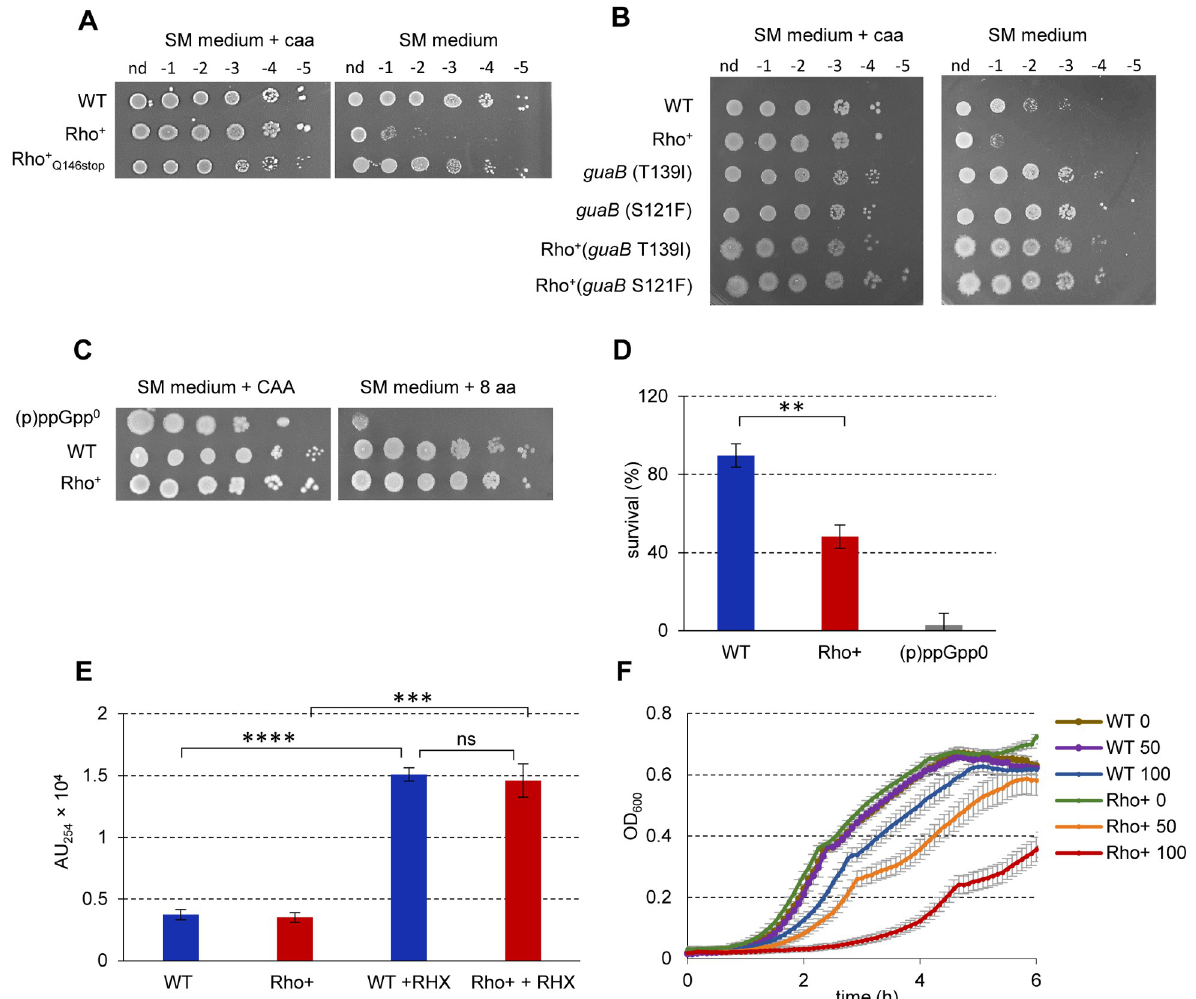
Fig 8. Adaptation of B . subtilis Rho + cells to a sudden nutrient downshift. ( A ) Rho + cells exhibit phenotypic amino acid auxotrophy. B . subtilis WT, Rho + and Rho + Q146Stop cells growing exponentially (OD 600 0.5) in liquid S7 medium containing 0.5% (w/v) of casamino acids (CAA) at 37˚C were spotted in serial dilutions on SM agar plates supplemented or not with CAA (0.5%). Plates were incubated at 37˚C during 18h before imagining. ( B ) Decreasing of GTP levels rescues the auxotrophic phenotype of Rho + cells. B . subtilis WT, Rho + and their respective derivative strains carrying guaB S121F and guaB T139I mutations were cultivated in liquid S7 medium containing 0.5% (w/v) of CAA and tested for the ability to grow in the absence of CAA as in (A). ( C ) Unlike (p)ppGpp 0 cells, the Rho + strain resists to mild nutrient limitations. Isogenic WT, (p)ppGpp 0 and Rho + strains were grown in liquid defined SM medium containing 0.5% (w/v) of CAA and spotted in serial dilutions on SM agar plates supplemented either with 0.5% (w/v) of CAA or with 0.05mg/ml of each of the eight amino acids (valine, isoleucine, leucine, threonine, histidine, arginine, tryptophan and methionine). Plates were incubated at 37˚C during 18h before imaging. In (A, B and C), the experiments were reproduced at least three times and the representative results are shown. ( D , E and F ) Rho + cells exhibit altered resistance to arginine hydroxamate (RHX). ( D ) Isogenic B . subtilis WT, (p) ppGpp 0 and Rho + strains were grown to the middle exponential phase (OD 600 0.5), treated with 500 μ g/ml of RHX for 40 min and plated on LB agar plates. Plates were incubated for 18 h at 37˚C before counting viable cells that formed colonies. Strain survival upon sudden amino acid starvation induced by RHX was estimated as the percentage of viable cells after and before the treatment. Plotted are the average values and SD from three independent experiments incorporating three biological replicas of each strain. Statistical significance was estimated with a two-tailed t-test. The displayed p-value: �� , p � 0.005. ( E ) Increase of ppGpp level following sudden amino acid starvation. B . subtilis WT and Rho + cells were grown in SM medium supplemented with 0.5% (w/v) of CAA to the middle exponential phase (OD 600 0.5) and treated or not with 500 μ g/ml of RHX. Cells were harvested 20 min after addition of RHX, and ppGpp levels were assessed as described (Materials and methods). Plotted are the average values and SD from three independent experiments. The displayed p-values are as follows: ���� , p � 0.0001; ��� , p � 0.001; ns (non-significant), p > 0.05 using two- tailed t-test. ( F ) Growth defect of the Rho + strain in the presence of RHX. B . subtilis WT and Rho + strains were cultivated in LB medium without or with RHX added at concentrations 50 and 100 μ g/ml in a 96-well microplate. Growth of the cultures was monitored by OD 600 measurement at the five-minute intervals using a microplate reader. Plotted curves are the average OD reads of two independent cultures of each strain grown in triplicates at each condition. The analysis was performed three times; the results of a representative experiment are presented.